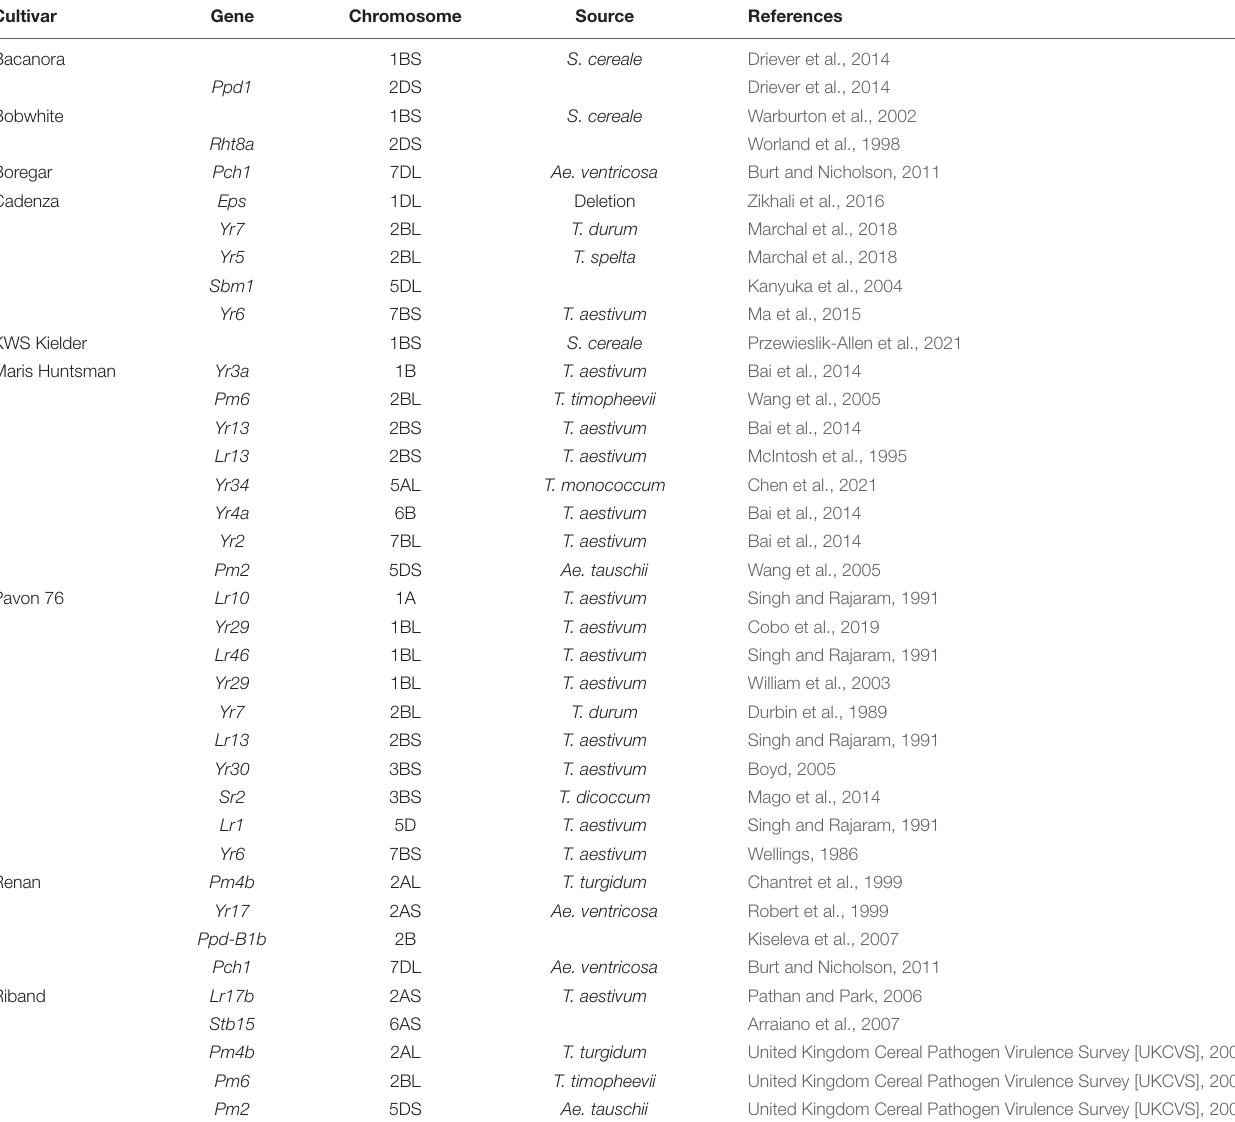
TABLE 2 | Introgressions and deletions reported in the literature for the accessions in this study. Cultivar Gene Chromosome